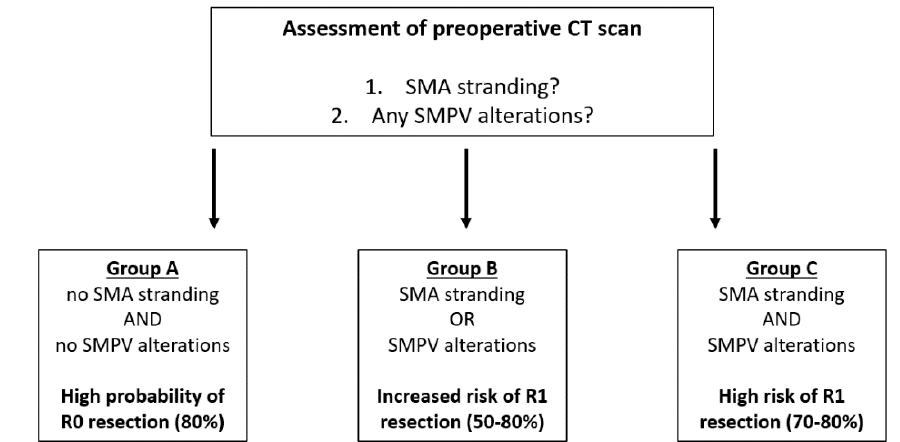
Figure 1. A novel scoring system for borderline resectability. SMA: superior mesenteric artery; SMPV: superior mesenterico-portal vein.